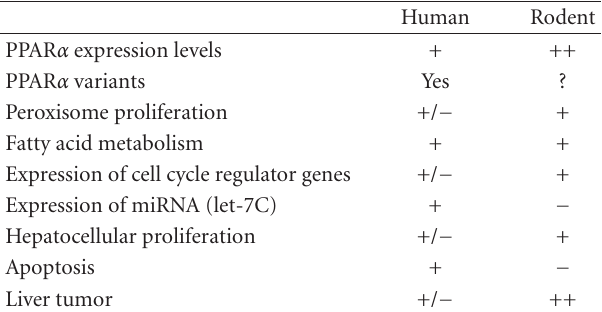
Table 1: Summary of the species di ff erences of PPAR α